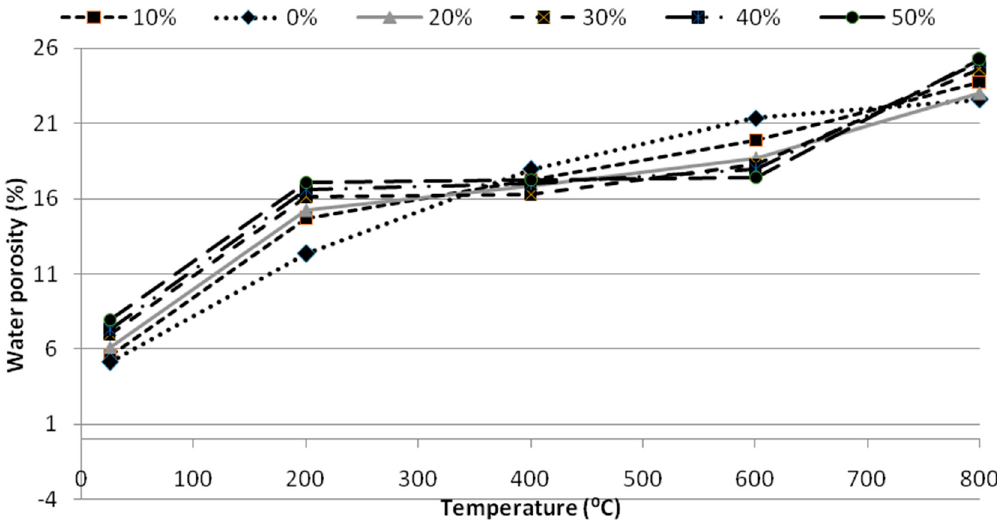
Figure 8. Porosity percentages of the SCGM at various temperatures.